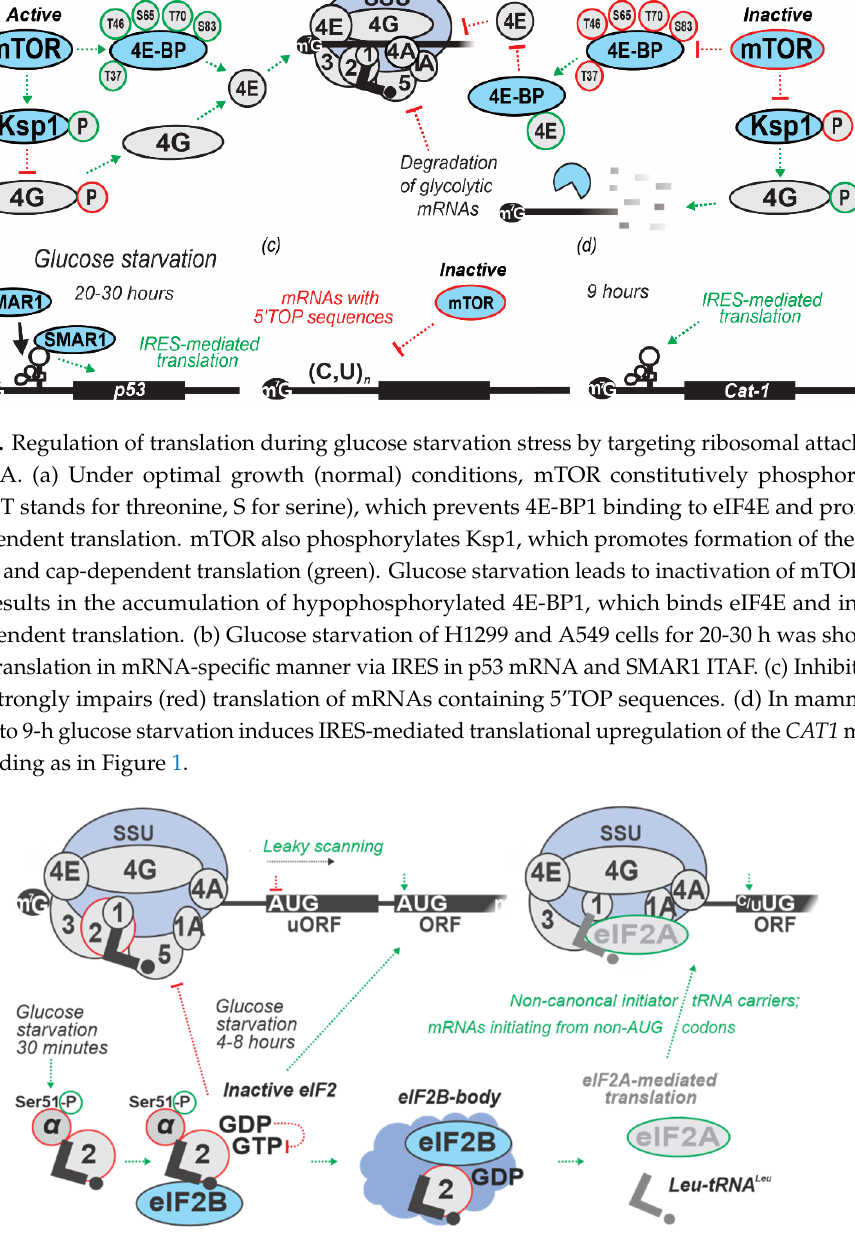
Figure 3. Regulation by targeting start codon recognition. Glucose starvation of ~4 h induces eIF2 α phosphorylation by kinases, such as GCN2/PERK, which inhibits eIF2B recycling resulting in low levels of active eIF2 for the next round of scanning, which results in the increase of leaky scanning (between 4–8 h of starvation). Post 30 min of starvation, eIF2B-bodies begin to form, containing eIF2B and eIF2. It is also possible that during low levels of eIF2, alternate factors, such as eIF2A, are used more frequently during start codon recognition. Color coding as in Figure 1.